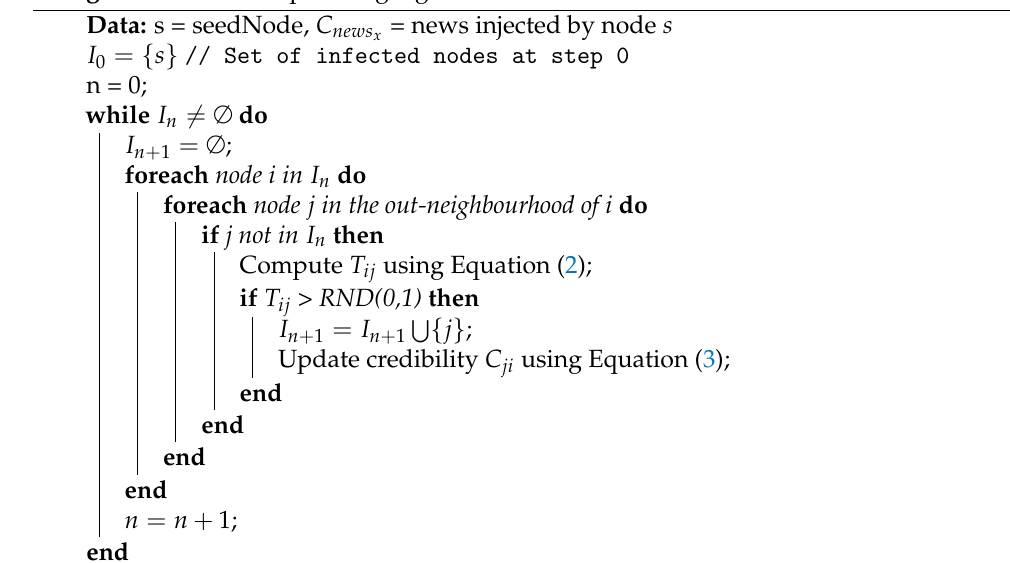
Algorithm 1: News spreading